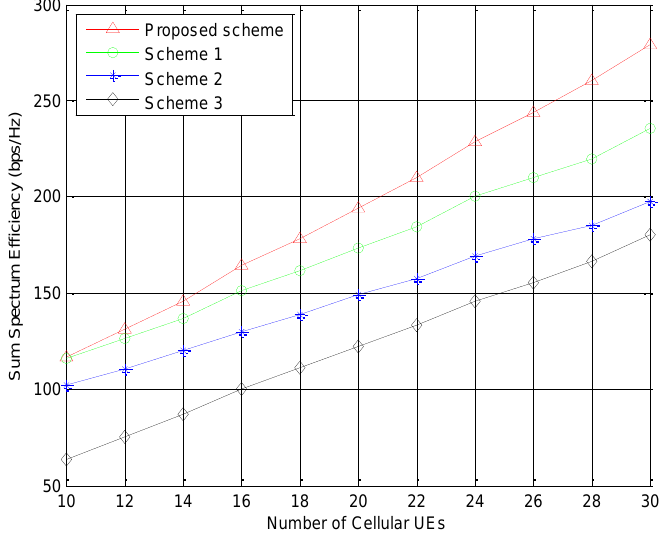
Figure 3. The sum spectrum efficiency versus the number of CUs M .